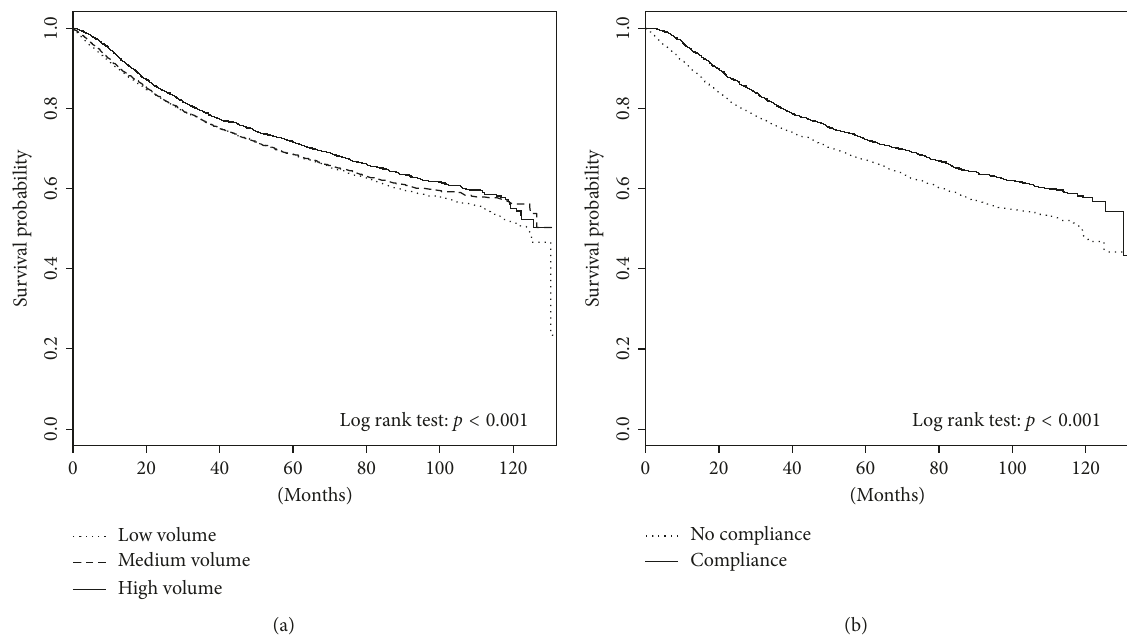
Figure 1: Kaplan–Meier plots of overall survival stratified by (a) hospital surgical volume and (b) adherence to NCCN